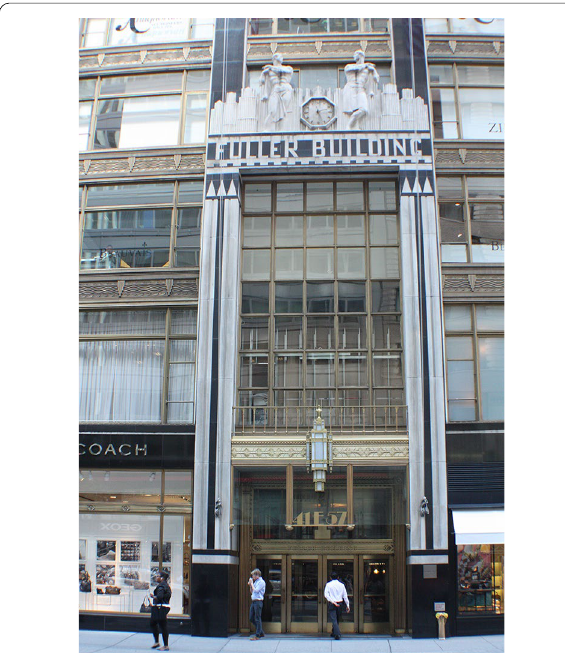
Fig. 10 The curtain wall of the Seagram in New York expresses order